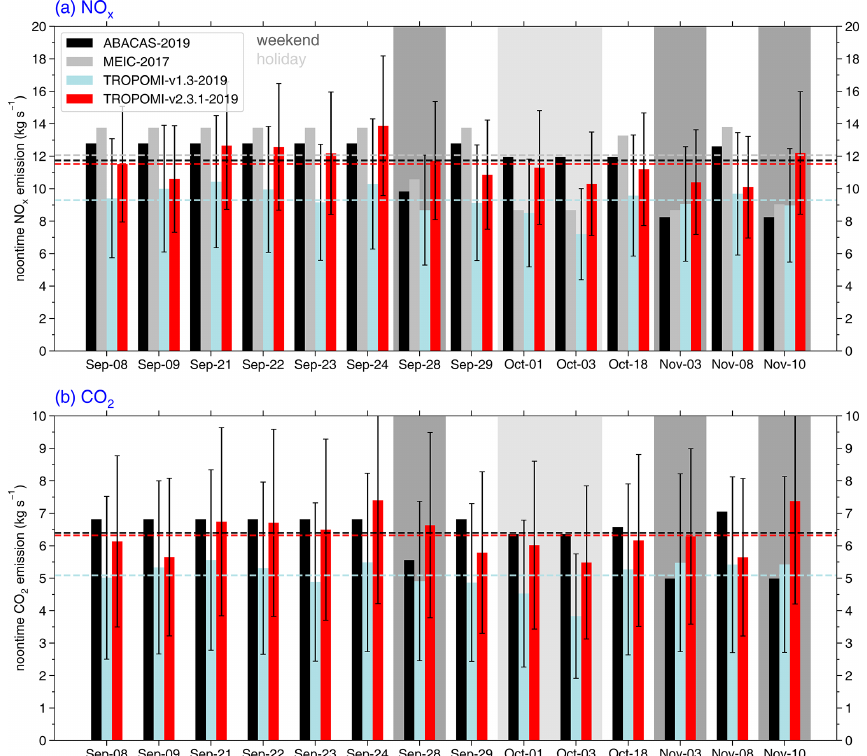
Figure 3. Daily noontime (a) NO x and (b) CO 2 emissions in Wuhan estimated from TROPOMI (red and blue bars; the error bars represent the uncertainty in the emission estimations) and the bottom-up emission inventories ABACAS (black bars) for the year 2019 and MEIC (silver bars) for the year 2017. The dark- and light-grey shades represent weekends and holidays, respectively. The mean levels of each dataset are given as dashed lines with corresponding